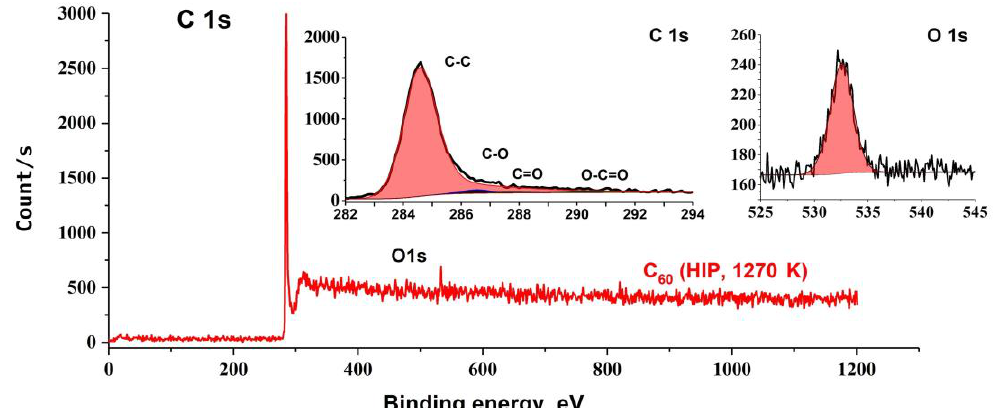
Figure 6. Survey XPS spectra of the fullerite C 60 subjected to HIP treatment at 1270 K and subsequently exposed to air for a long time. The insets show C 1s and O 1s core-level XPS spectra.